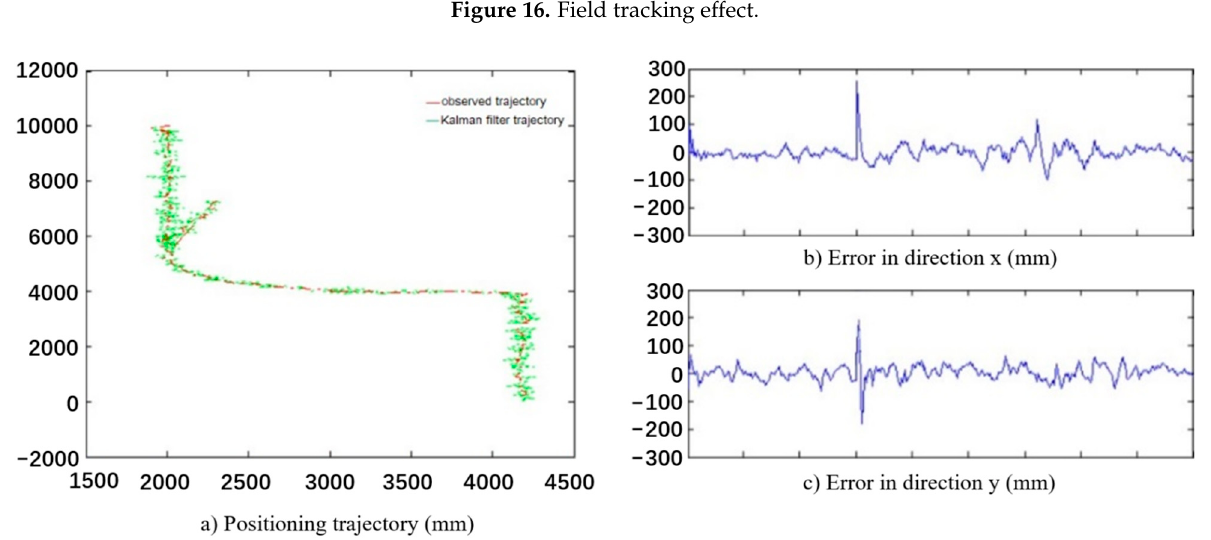
Figure 17. Result of tracking algorithm.